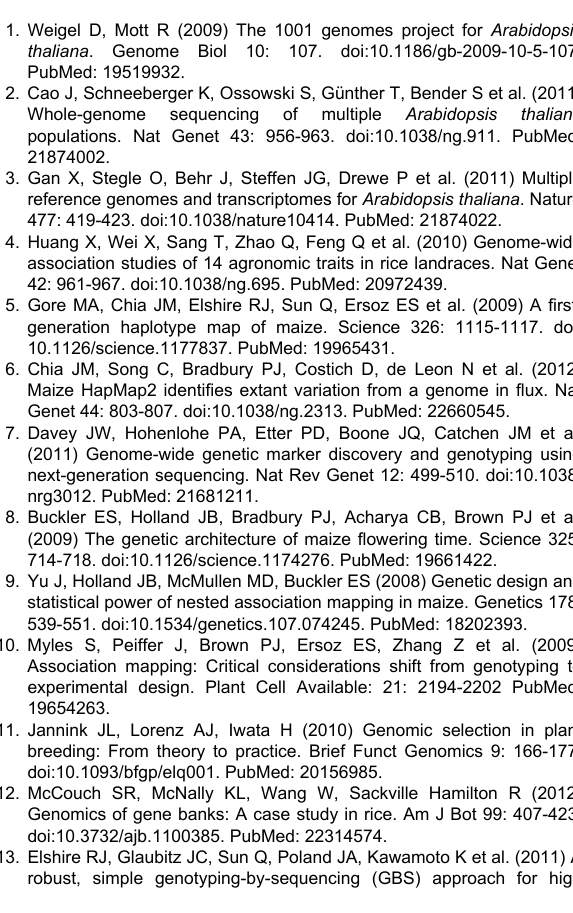
Table S2. Sequence of 384 bar code adapters designed for Ion Torrent.